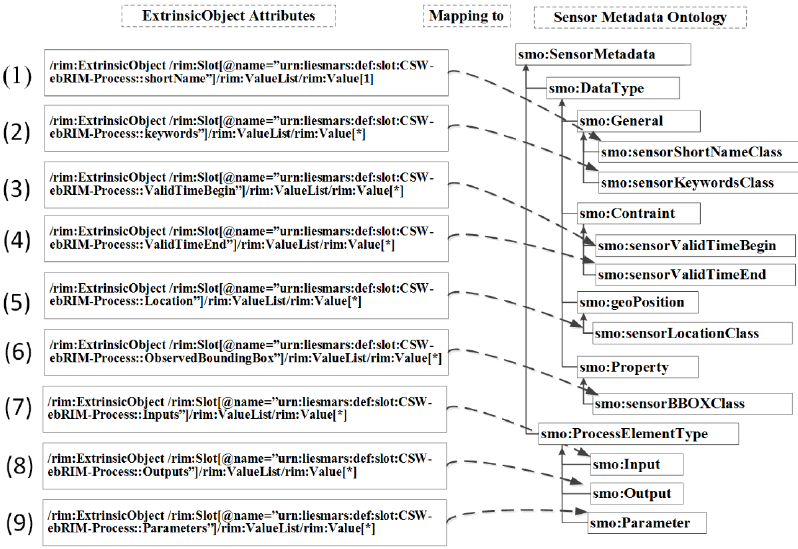
Figure 3. The mapping of ExtrinsicObject slots.